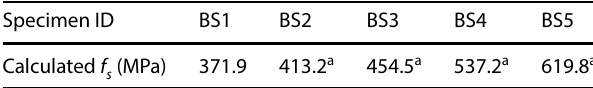
a Higher than yield stress